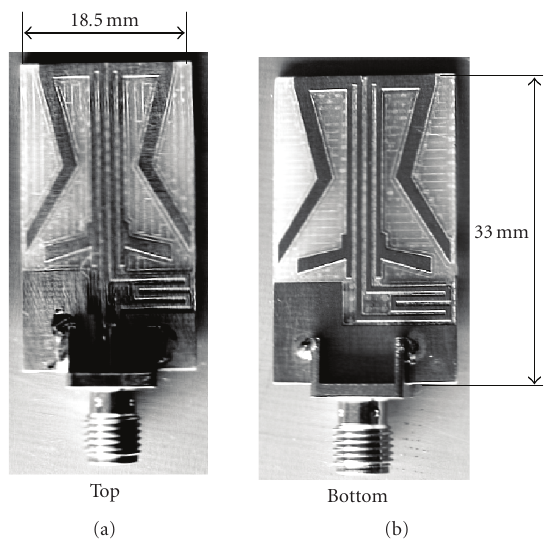
Figure 6: Simulation and experiment for the GPS antenna return loss.